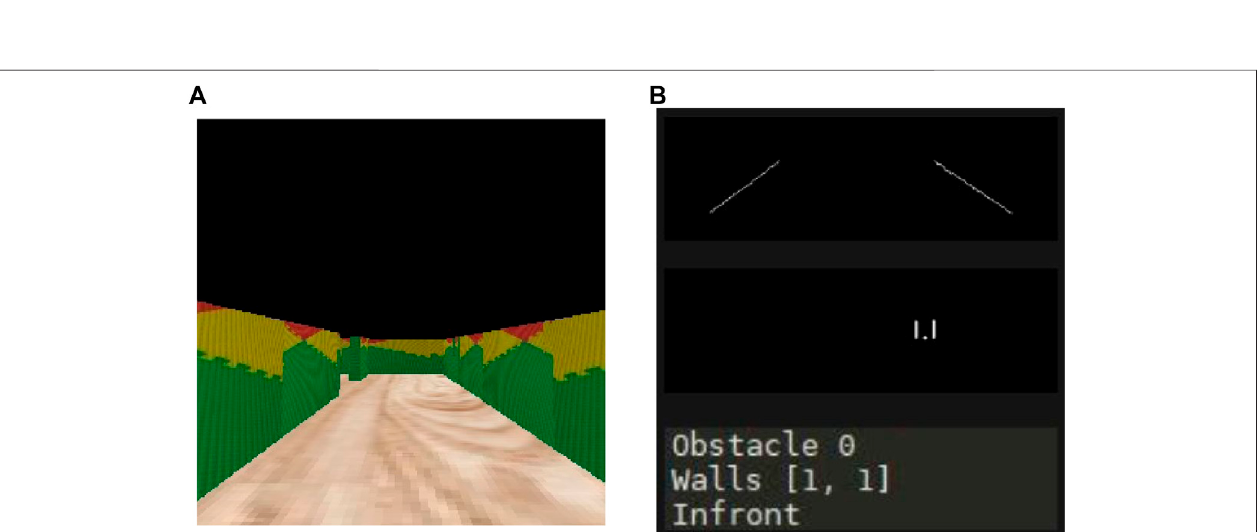
FIGURE 6 | Mapping and path planning integration. First demo. (A) What the robot sees. (B) Algorithms output.